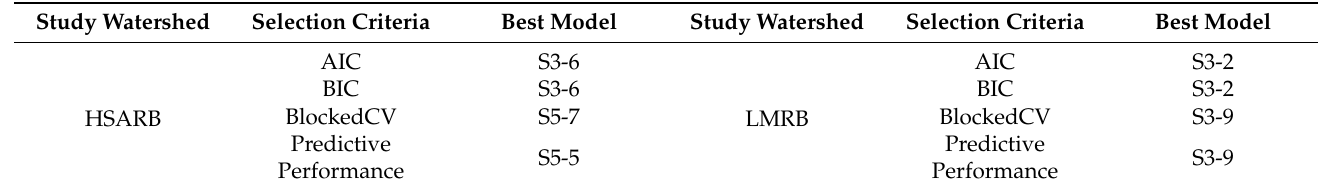
Table 7. Selected best model structure with different